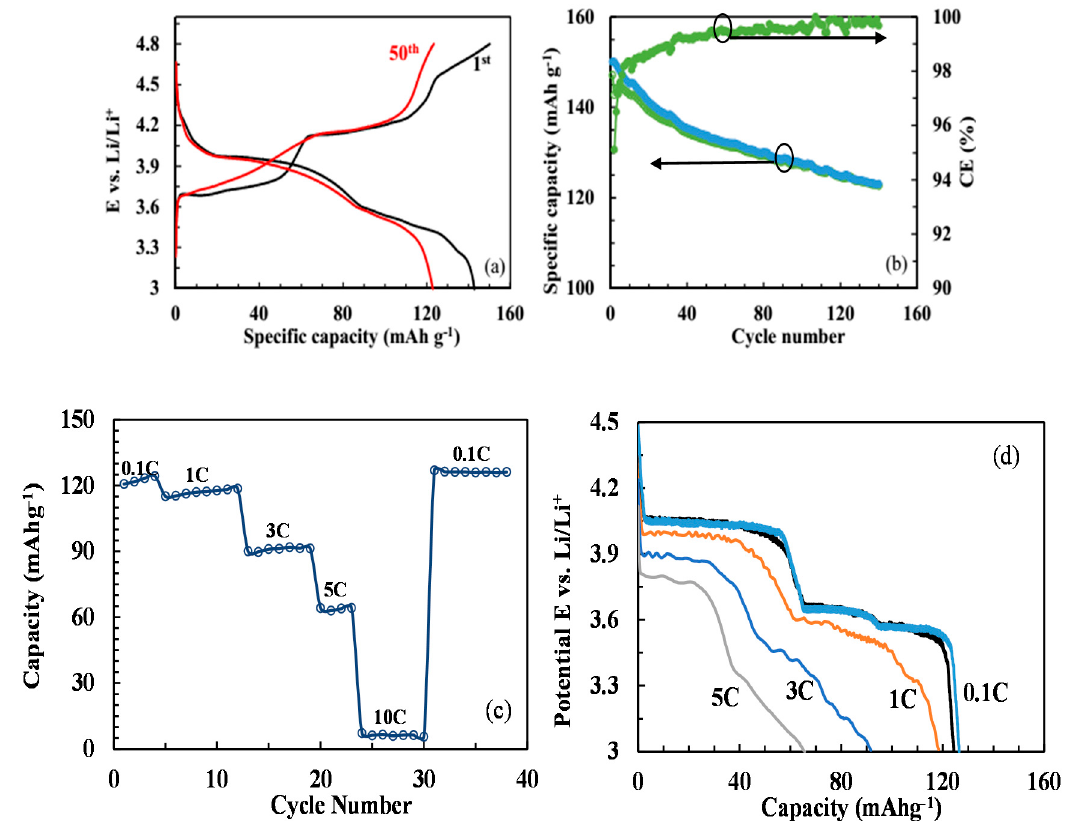
Figure 7. ( a ) Initial and 50 th charge/discharge curves, ( b ) cyclic performance, ( c ) rate performance and ( d ) charge/discharge curves of the LVP compounds prepared by the oxalic acid in the potential (E) range of 3.0–4.8 V Vs. Li.